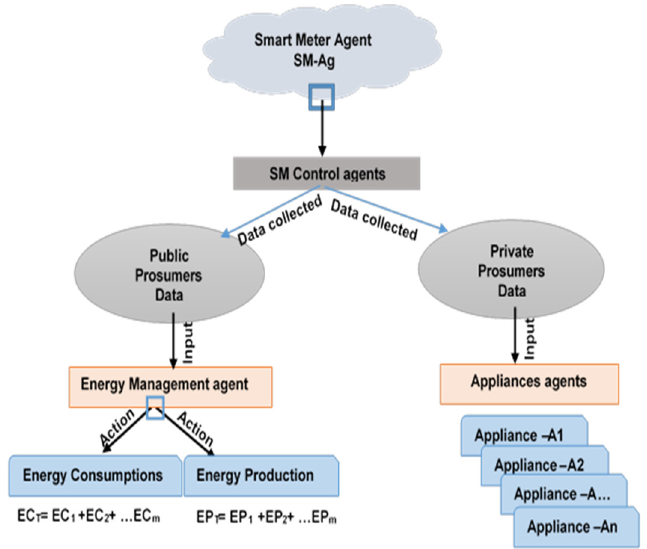
Figure A4. Data Collected by SMAs .